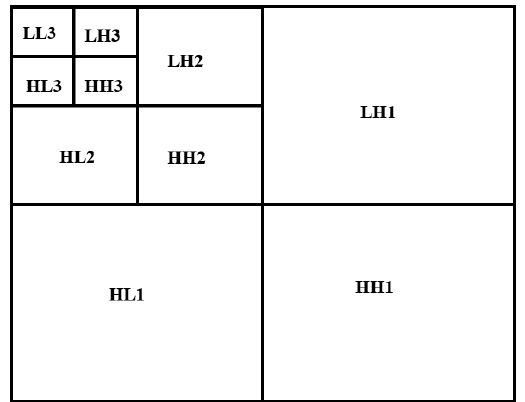
Figure 1. Three level 2D DWT image dissolution